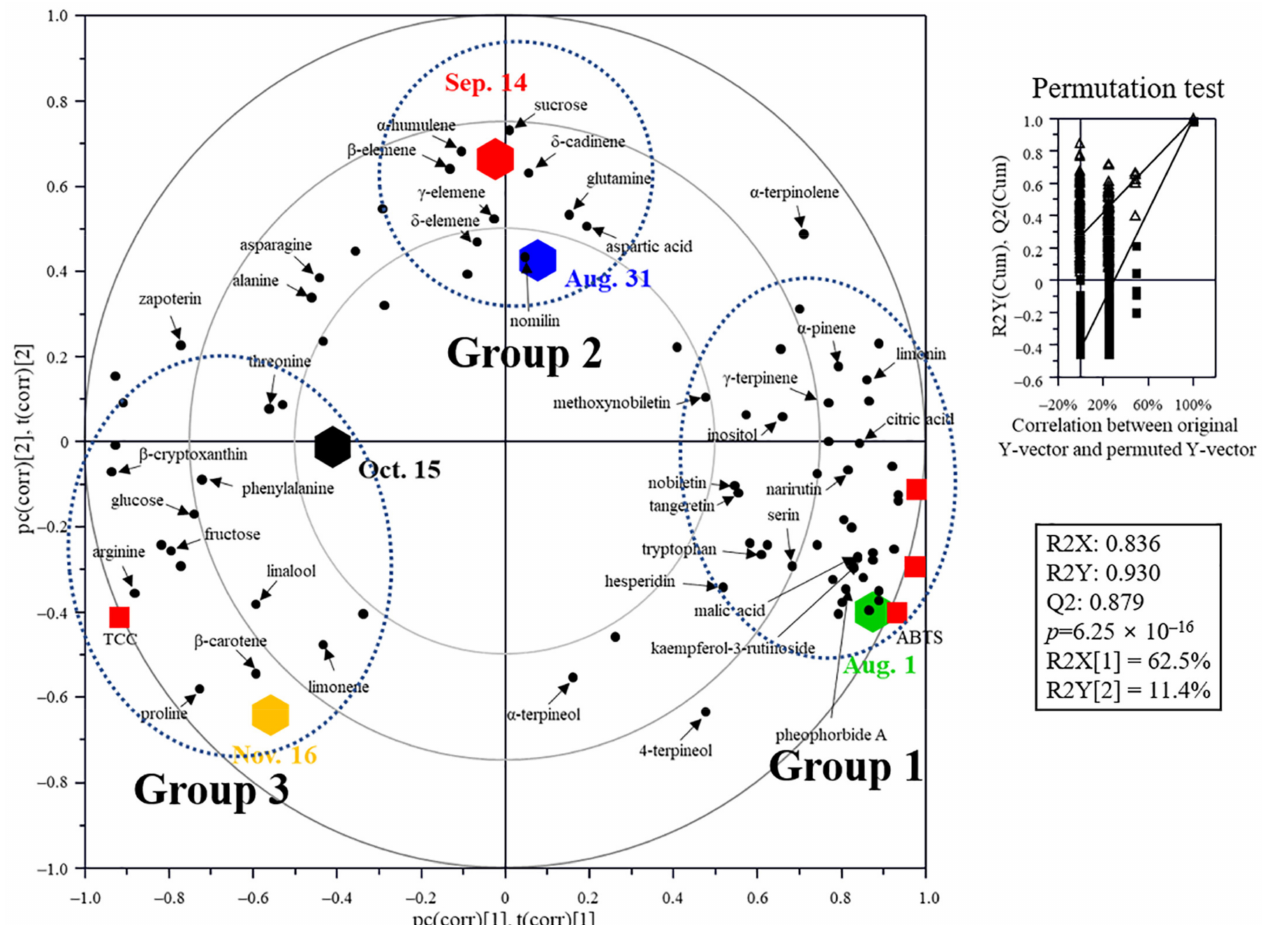
Figure 5. PLS-DA biplot of Citrus unshiu flesh during fruit development based on the total phenolic content (TPC), total carotenoid content (TCC), antioxidant activities (DPPH and ABTS), and metabolite profiles. The statistical acceptability was evaluated by quality parameters (R2X, R2Y, Q2, and p -value) and validated by cross validation with a permutation test (n =